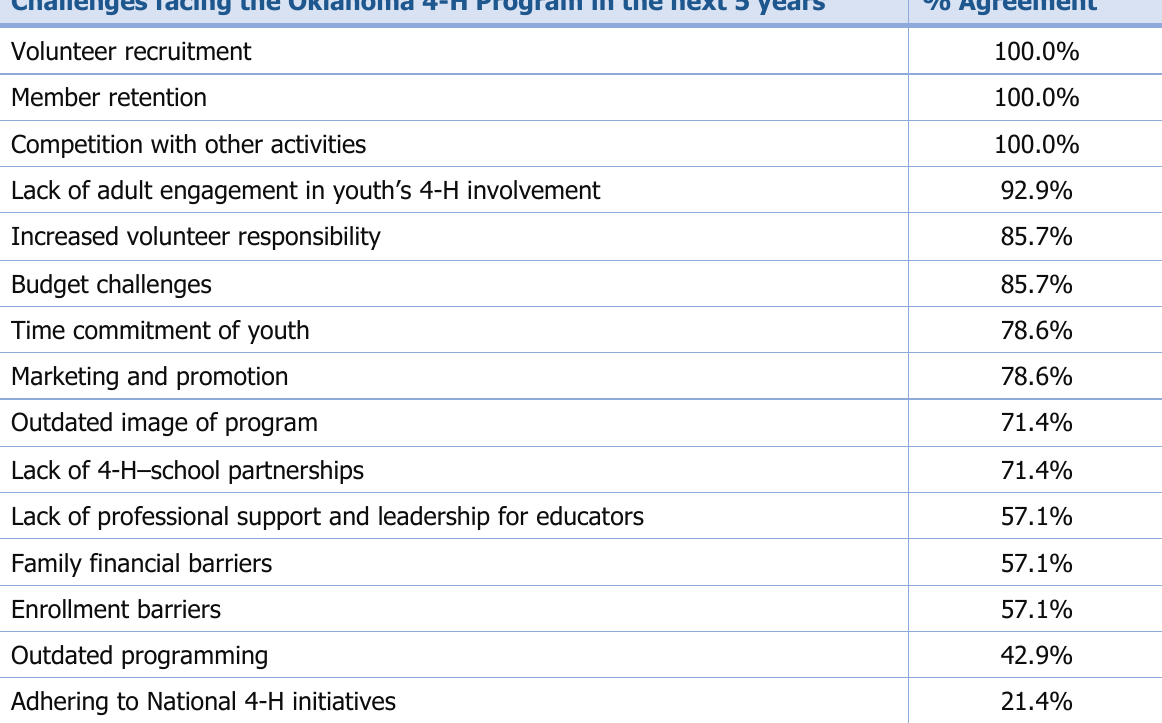
Table 2. Challenge Statements and Agreement Percentages in Round 2: Panel 2 Challenges facing the Oklahoma 4-H Program in the next 5 years